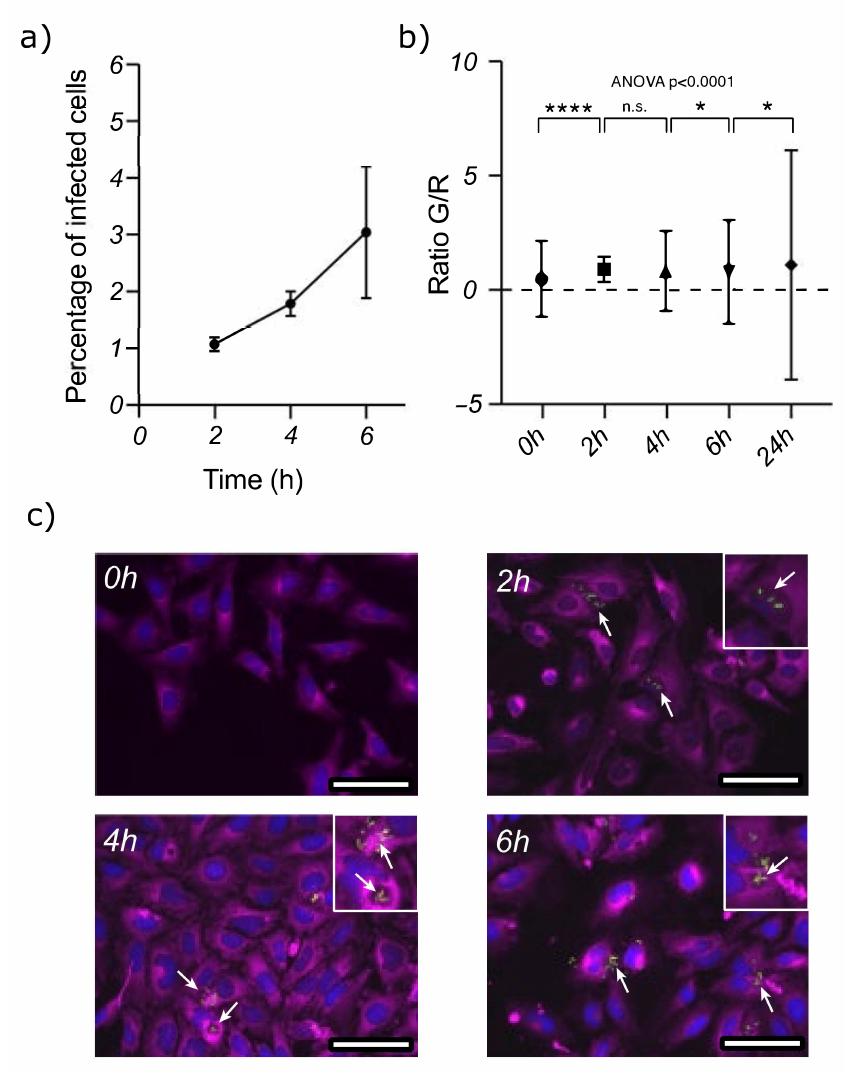
Figure 1. A. baumannii is able to survive intracellularly in HeLa cells. ( a ) This graph represents the A. baumannii infection rate in the HeLa cells; the X-axis relates to 3 time-points: 2, 4 and 6 hours post infection (HPI), and the Y-axis represents % of infection. The data show an increase in the number of infected cells at different HPI. ( b ) Flow cytometry of the cells infected with A. baumannii at the different HPI. A. baumannii carries a plasmid expressing the TIMER protein [24,25], enabling the tracking of intracellular-bacteria survival inside HeLa cells. The X-axis represents different time- points: 2 (in blue), 4 (in red) and 6 HPI (in green), and the Y-axis shows the green/red fluorescence ratio (G/R). A higher G/R ratio indicates that A. baumannii cells are replicating faster. ( c ) Fluorescence microscopy images (left to right) at 2, 4 and 6 HPI. The plasma membrane and nuclei of the HeLa cells were stained with CellMask (purple) and DAPI (in blue), respectively. The bacteria were detected using TIMER fluorescence. Bacteria foci details are shown as inserts in the top-right corner of each image. Scale bars represent 125 µ m length. In all plots, standard error of the mean is represented by vertical bars. One-way ANOVA was used to determine whether there are any statistically significant differences between the means of two or more independent groups in the time series. Individual groups were compared using a two-tailed t -test: * p < 0.05, **** p < 0.0001, n.s. not significant. The A. baumannii cells were labeled with the TIMER protein to investigate whether they could grow intracellularly [24,25]. The fluorescence of TIMER is dependent on maturation and shifts from green to orange. When cells divide faster, the dilution of TIMER in the daughter cells remains fluorescent green. However, when cells do not divide,